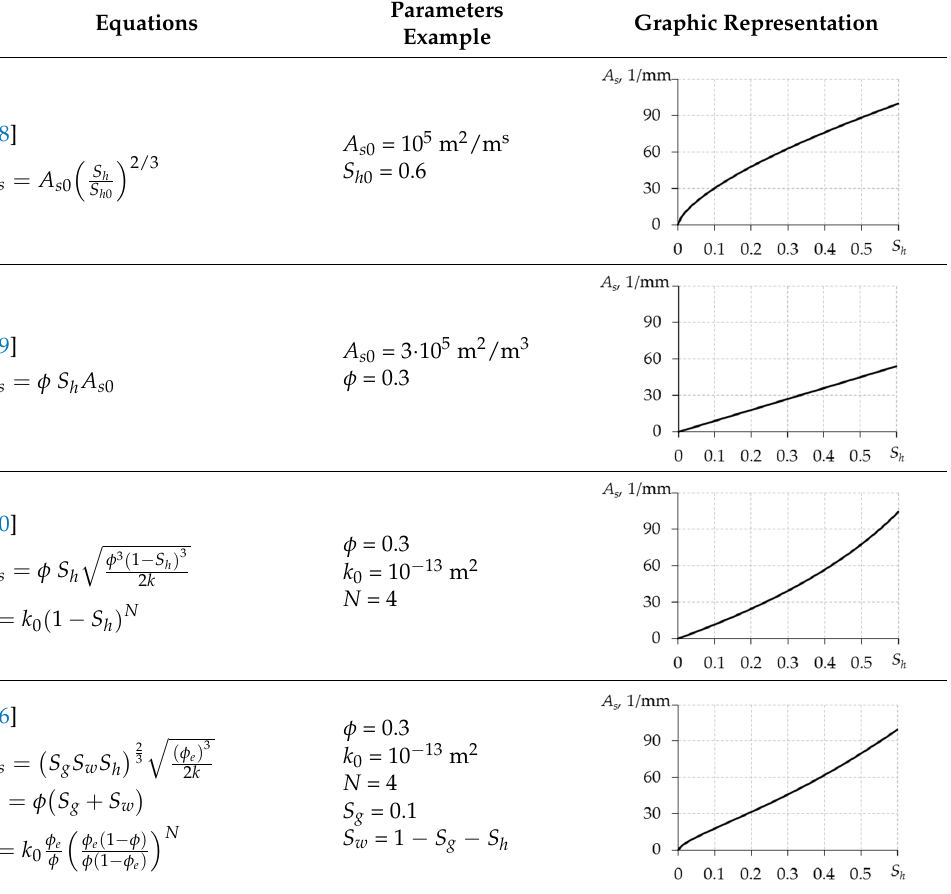
Table 3. Equations for calculating A s .